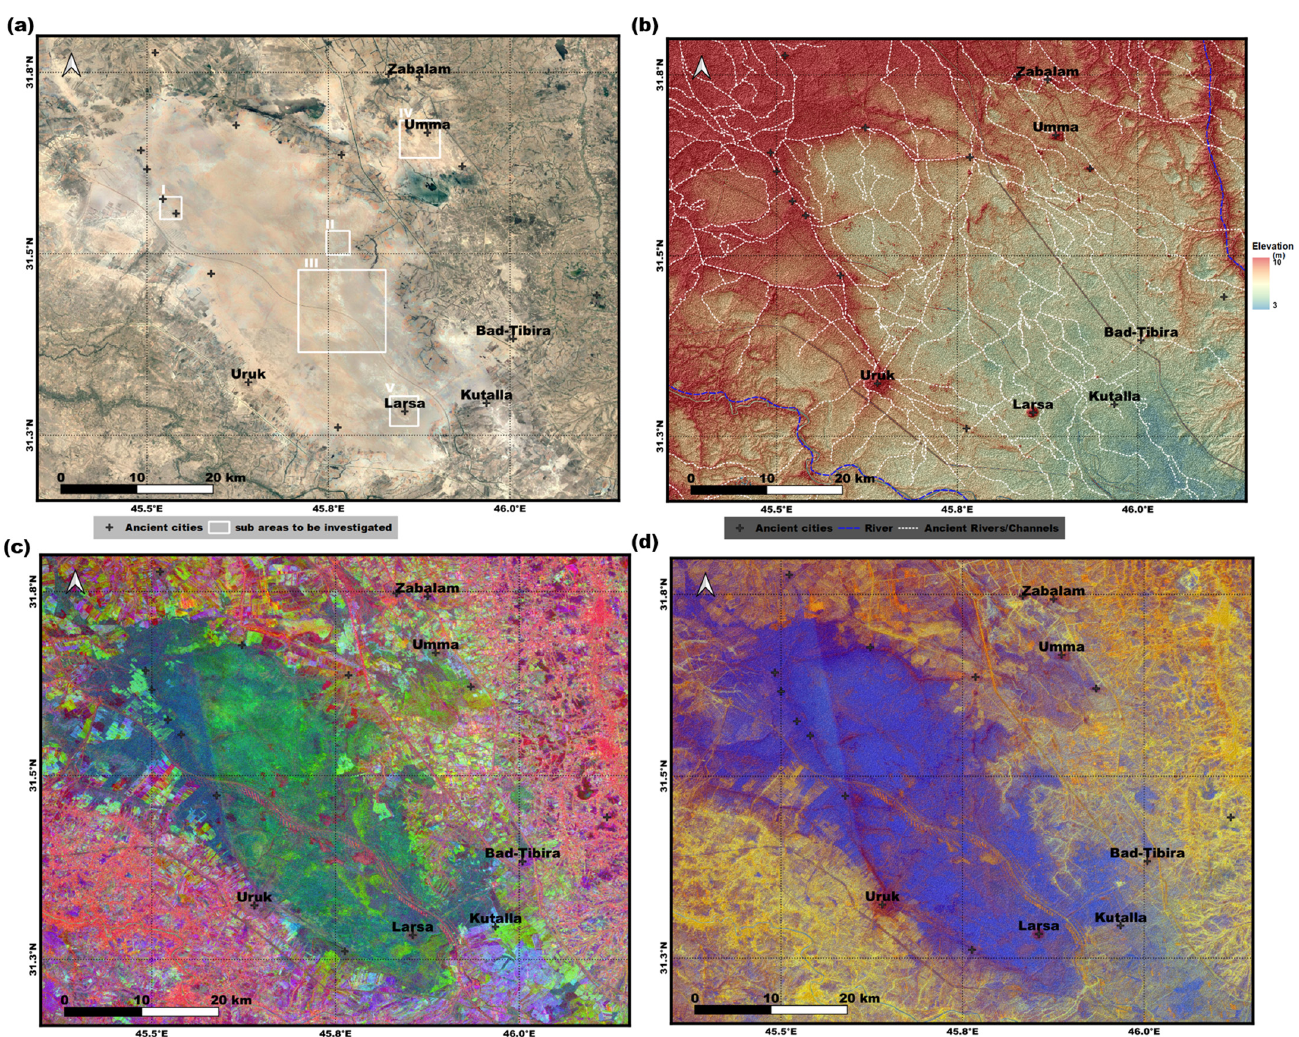
Figure 5. PALSAR-2 products in the Larsa-Uruk-Umma area are assigned as ROI-2. ( a ) Google Earth optical image of the corresponding optical image. ( b ) Copernicus 30 m DEM with paleochannels overlaid. PALSAR-2 HH TS Comp. products ( c ) (2016–2018). The following section contains an interpretation of the features assigned I through V. ( d ) 3 Ch/1 st Tr-SVD Comp.